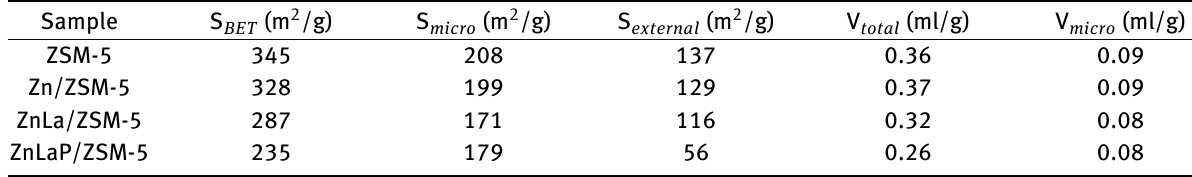
Table 10: Composition of FCC gasoline feed and product [60]